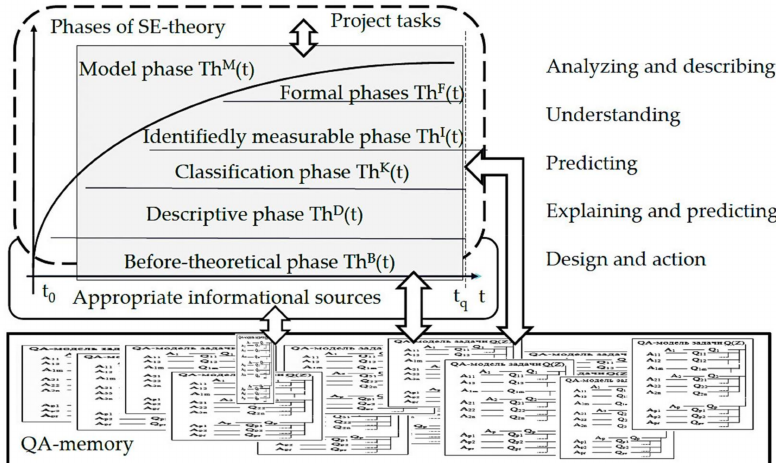
Figure 13. Phase structure of the theory of the